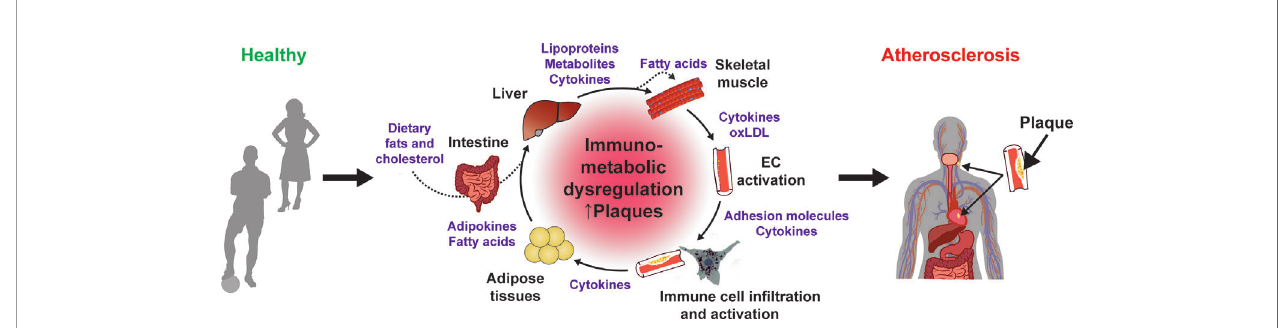
FIGURE 1 | Immunometabolic dysregulation promotes atherogenesis. Contribution of different organs and immunometabolic mediators to the chronic dysregulation that promote